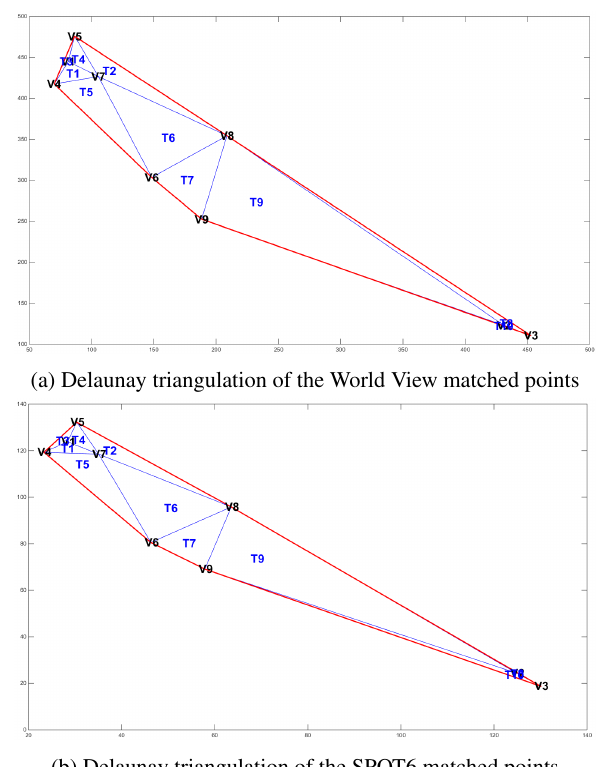
Figure 3: Delaunay triangulations of the matched points on both World View and SPOT6 patch number seven for distance thresh- old of 3. Labels with letter T in front represent number of triangle and those with letter V in front represent a vertex. The red poly- gon represents the convex hull of the triangulation in each case. The axes correspond to number of